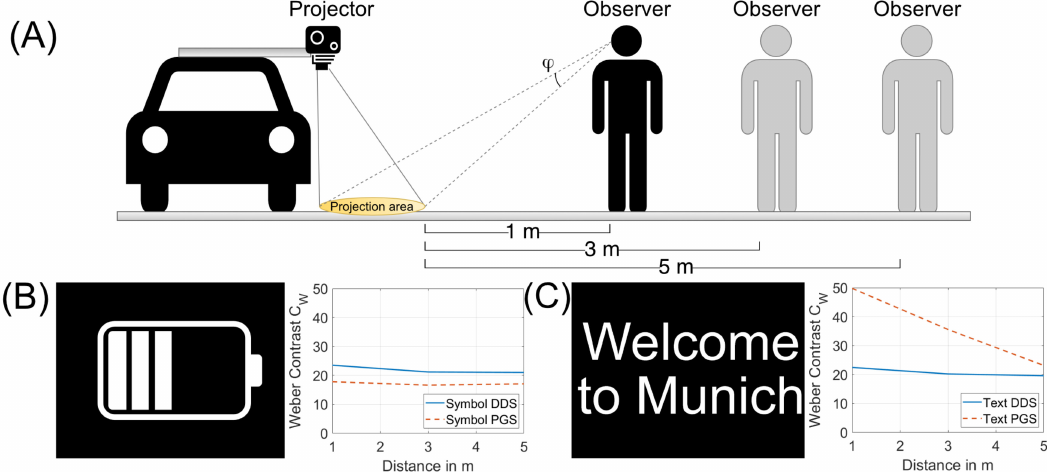
Figure 1. Schematic illustration of the experimental setup and used projection content in both studies. ( A ) The experimental setup for both studies, where a 3LCD laser projector [32] is mounted on a vehicle, indicates the three different viewing distances of 1 m, 3 m, or 5 m. Additionally, the observer’s viewing angle to the projection area for the 1 m viewing distance is illustrated. ( B ) Display of the symbol-based projection content and a graph with the contrast measurements in PGS and DDS related to the viewing distance. ( C ) Picture of the text-based content and the graph for the corresponding contrast in PGS and DDS related to the viewing